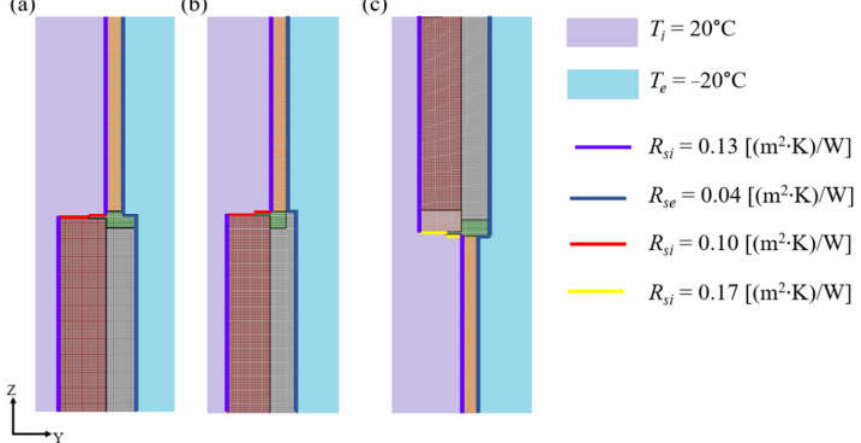
Figure 8. Numerical model and boundary conditions for cross-sections: ( a ) bottom, ( b ) side, ( c ) top.